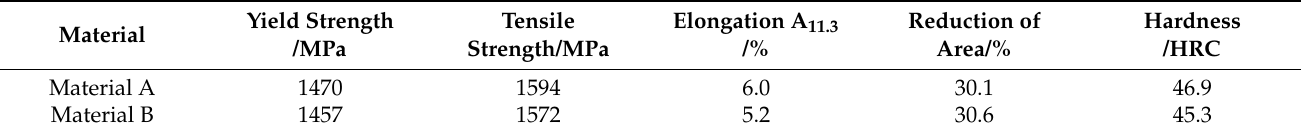
Table 2. Conventional tensile mechanical properties after heat